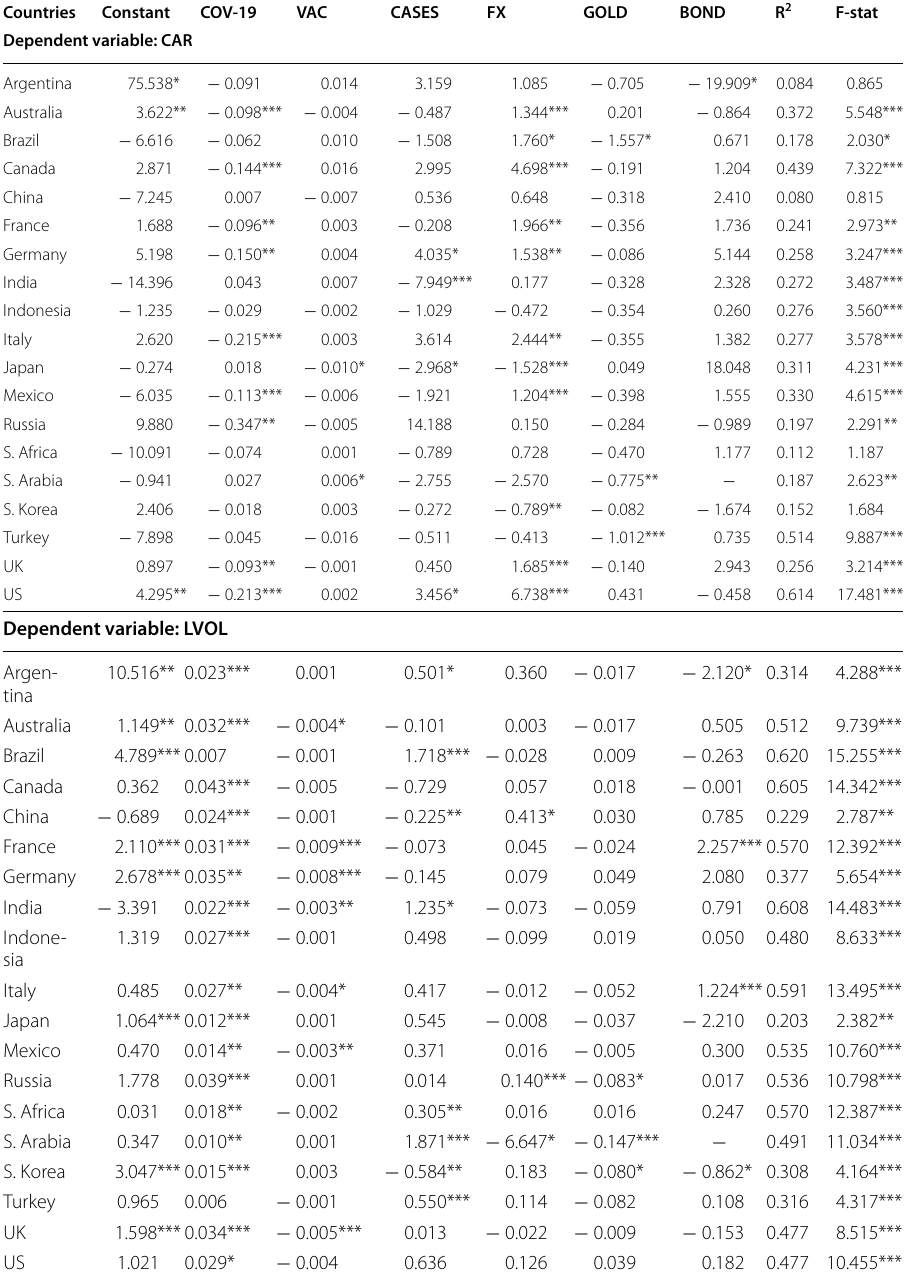
Table 12 Country regression model